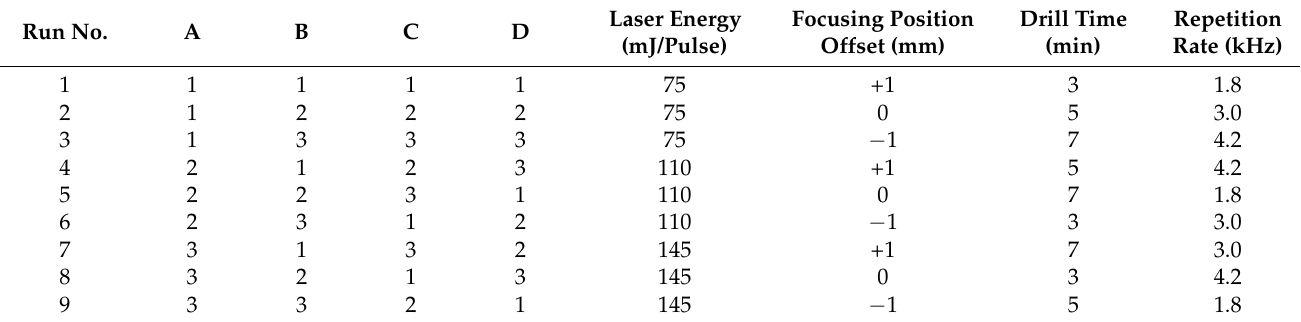
Table 3. Experimental design using L 9 (3 4 ) and four control